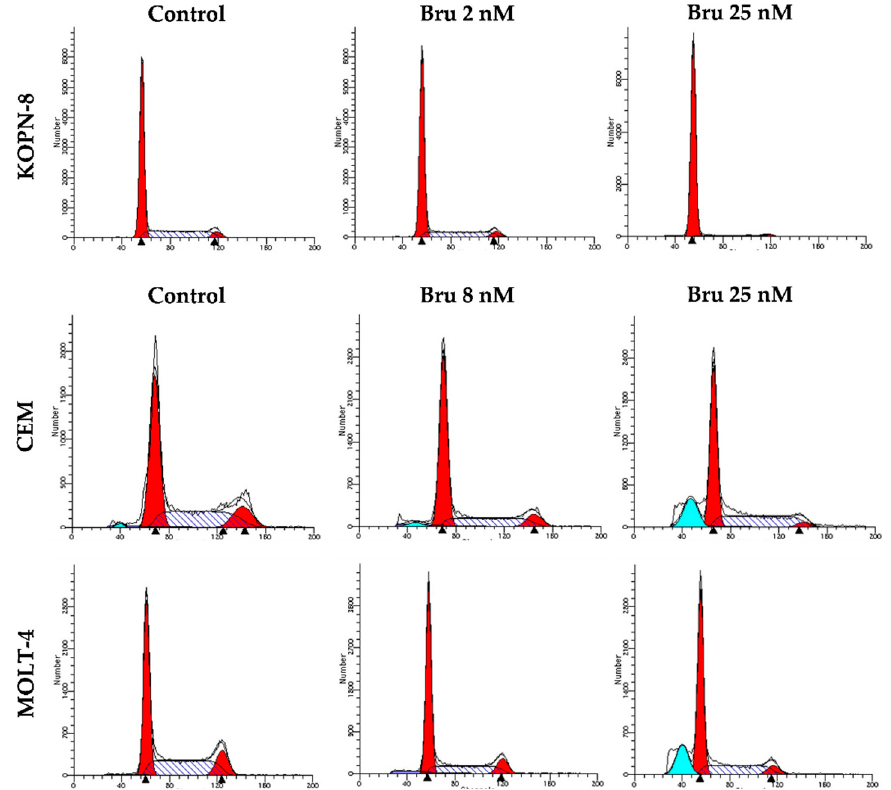
Figure 5. DNA-representative histograms of cell cycle analysis from acute lymphoblastic leukemia cell lines treated with brusatol. Cell cycle analysis was performed with propidium iodide/RNAse staining and analyzed by flow cytometry (FC). The initial and the last red peaks correspond to G 0 /G 1 and G 2 /M, respectively; between them is S phase. Sub-G 1 , when present, is represented in blue peak. Bru: brusatol.